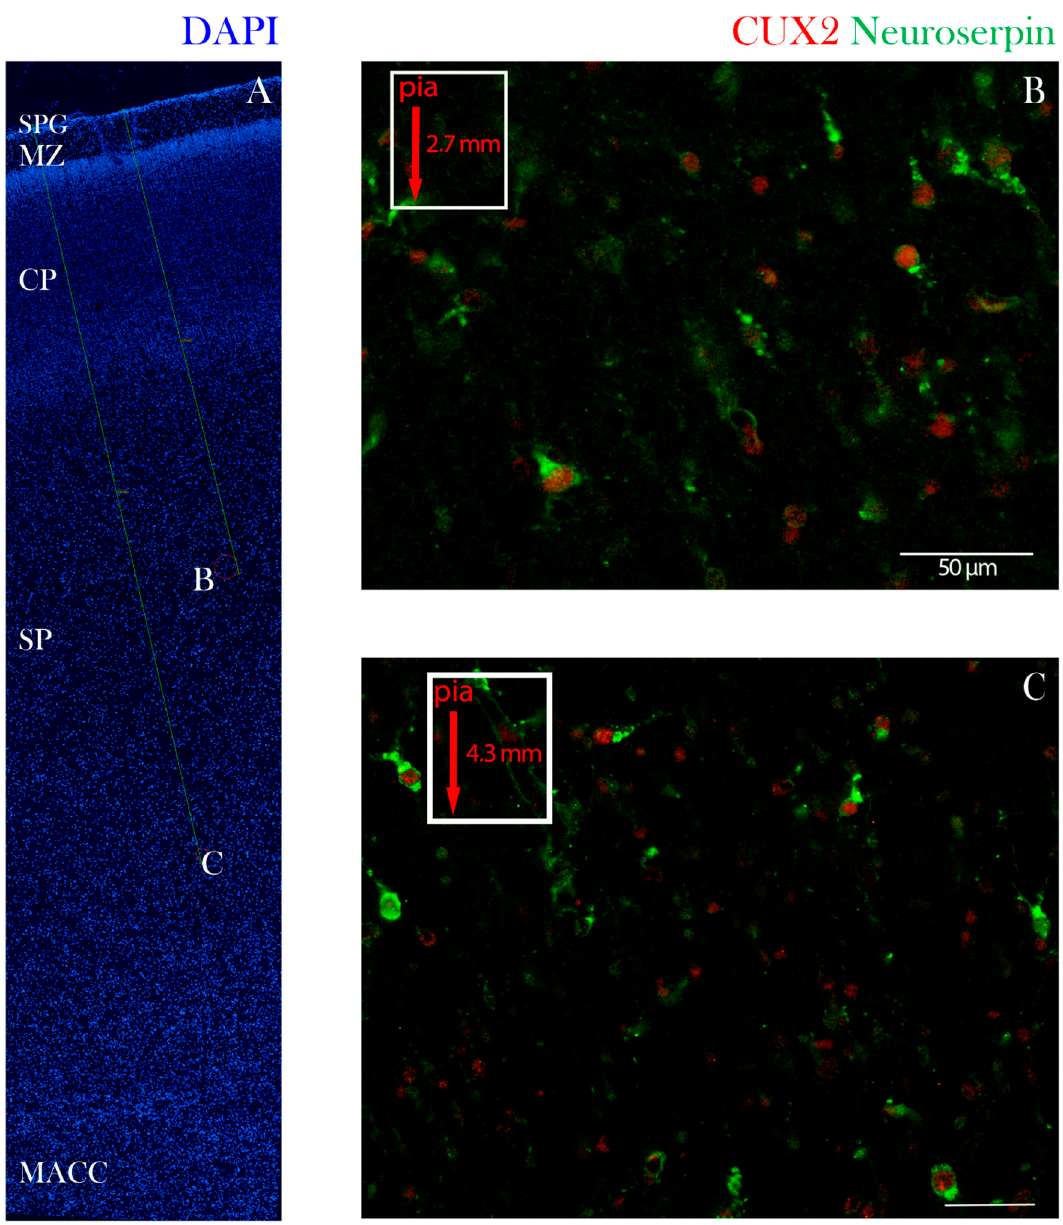
Figure 7. CUX2 is expressed in Neuroserpin expressing SP neurons at peak of SP stage at 24 PCW. Coronal section of developing dorsolateral neocortex was immunostained for CUX2 (red), SP marker Neuroserpin (green) and DAPI (blue) at 24 PCW. ( A ) Red circles denote position of images taken in B and C. A green line demarks the depth from the pial surface. ( B , C ) CUX2+ and Neuroserpin co-expression in the superficial SP (B; 2.7 mm from pia, ( B ) and deep SP ( C ); 4.3 mm from pia). Scale = 50 µ m ( B , C